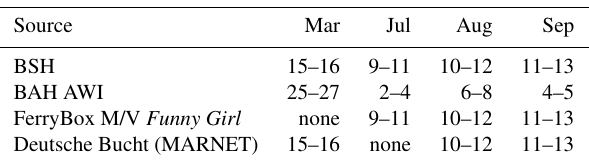
Table 4. Sampling dates of the different stations and platforms dur- ing different months in 2013.